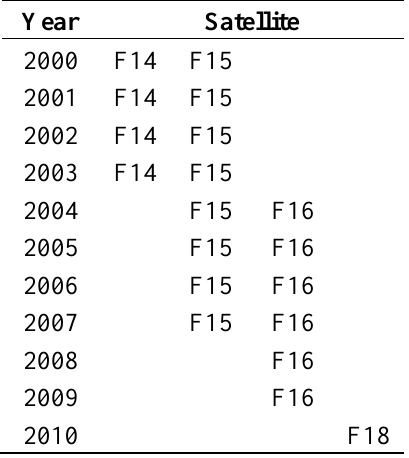
Table 1. A list of satellites used to produce annual NTL